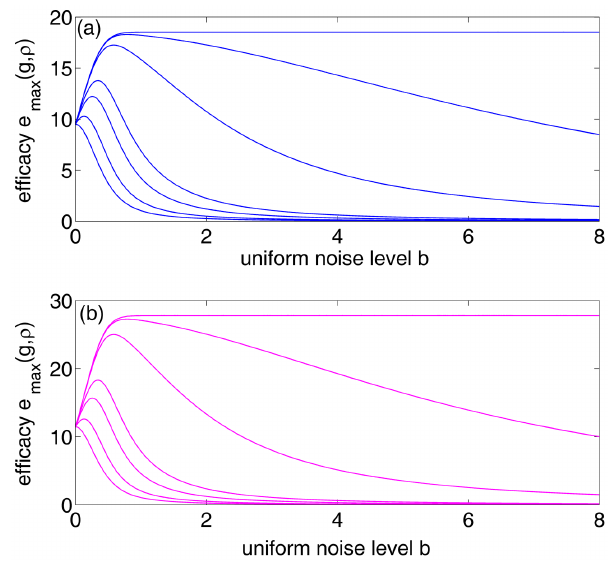
Figure 2. Stochastic resonance of a single threshold neuron. Detection efficacy of e max ( g , r ) as a function of noise variance ~ m 2 z E 2 for the correlation coefficient j r j ~ 0 : 2 and different values s 2 w of m ~ 0 : 3 (red), 0 : 5 (blue) and 1 (green). The resonant peaks of e max ( g , r ) are marked by the square ( & ), the star ( (cid:4) ) and the down triangle ( . ) for m ~ 0 : 3,0 : 5 and 1 , respectively. Here, the transfer function g ( x ) ~ sign ( x ) , and the noise distribution is Gaussian mixture model of Eq. (33).